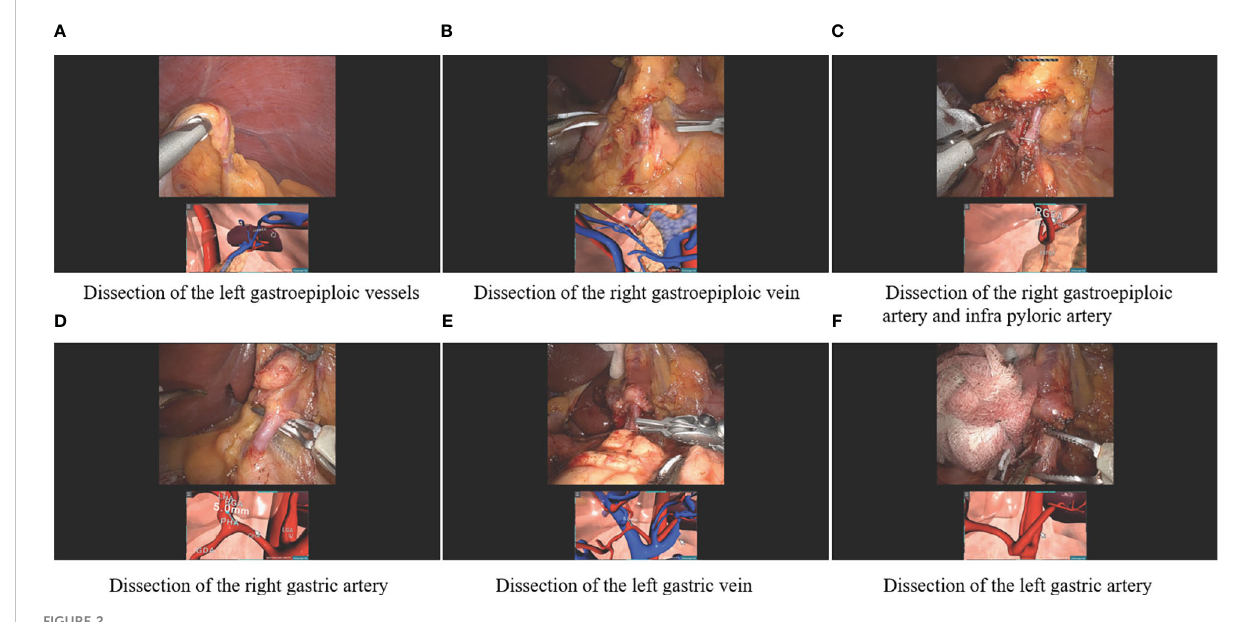
FIGURE 2 Robotic gastrectomy procedures using the patient-speci fi c virtual 3-D surgical navigation system according to the six pre-de fi ned points of interest (A) Dissection of the left gastroepiploic vessels, (B) Dissection of the right gastric vein, (C) Dissection of the right gastroepiploic artery and infra pyloric artery, (D) Dissection of the right gastric artery, (E) Dissection of the left gastric vein, and (F) Dissection of the left gastric